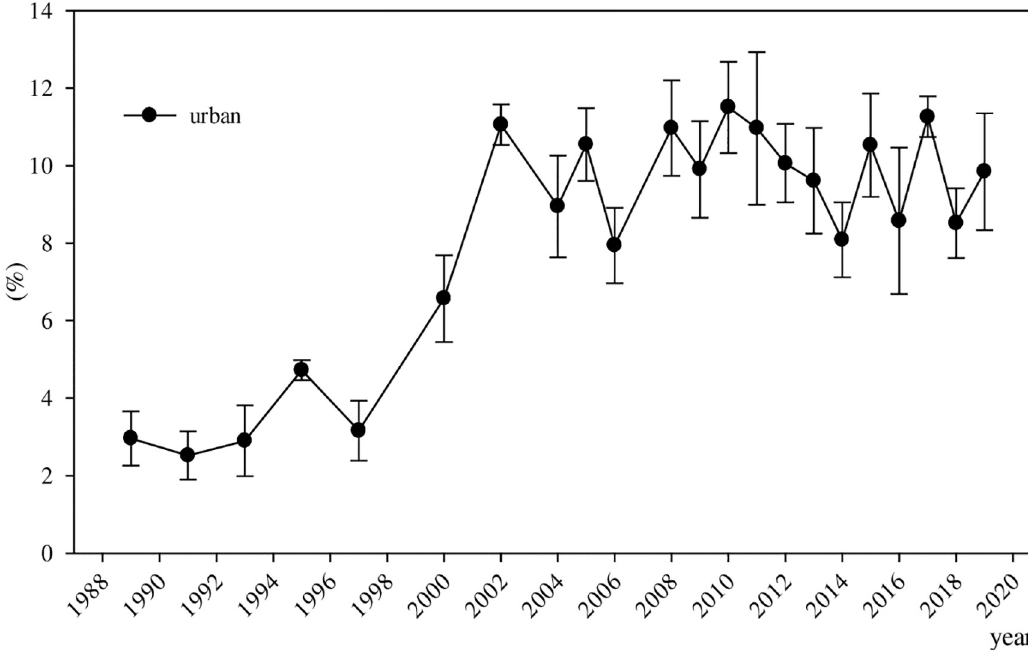
Fig 1. Evolution of returns to education in urban China. Data Source : CHNS, CHIP, CGSS, CFPS, CHFS, and CSS.